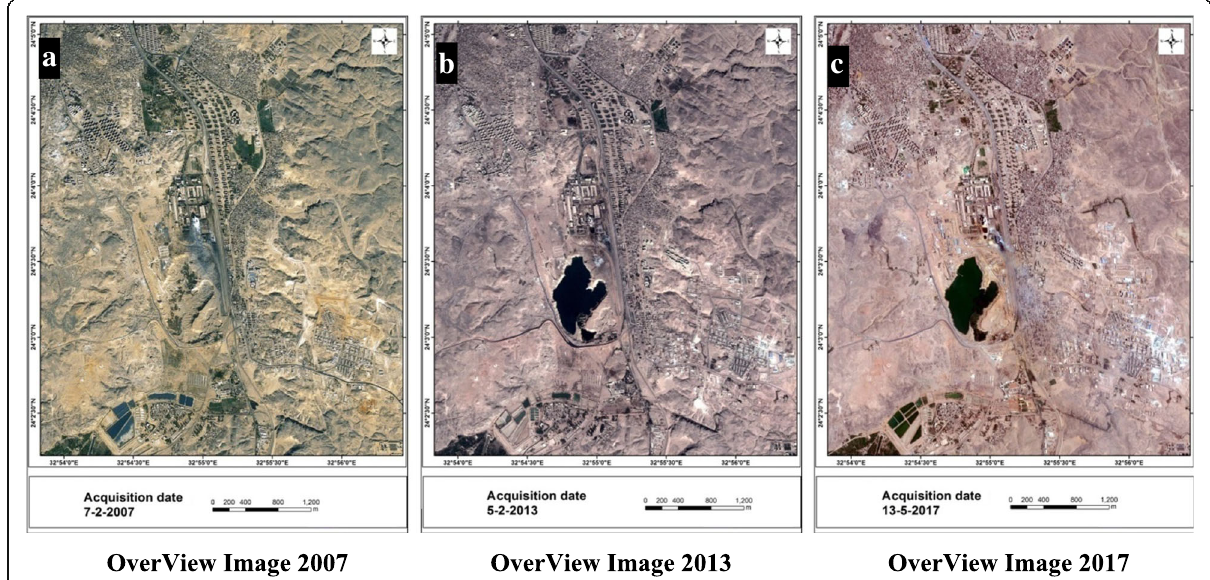
Fig. 4 Landsat images detect the environmental changes in the study area, a Overview Image 2007, b Overview Image 2013 and c Overview Image